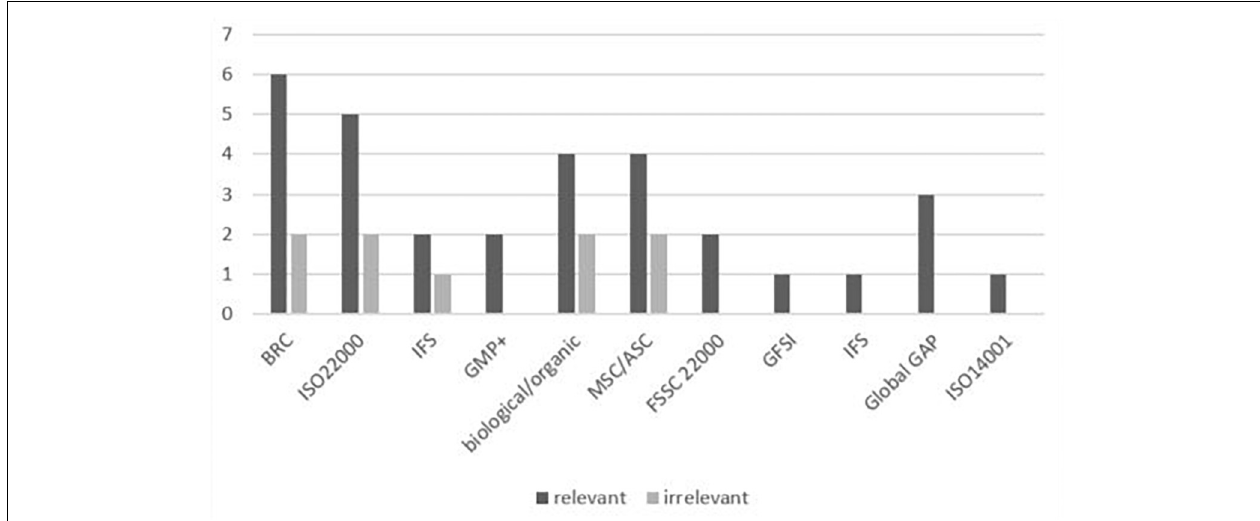
FIGURE 2 | Relevance of private standards accordings to responds. Not mentioned in text are GMP+, Global food safty Initiative (GFSI) and ISO14001. These standards are deemed relevant for seaweed by some of the respondents.